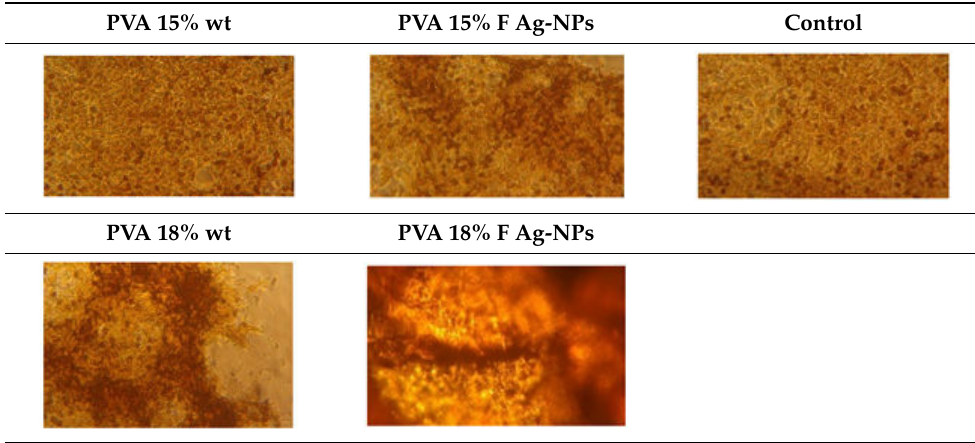
Figure 10. Alizarin red test for pure PVA and PVA/fibroin/Ag-NPs composite membranes on days 3, 7, and 10. Statistical analysis was developed with ordinary one-way ANOVA followed by Tukey’s multiple comparisons test, p < 0.05. **** high significant difference. Table 4. Optical micrographs of calcium deposition on PVA membranes cultured with MG-63 cells, with respect to the control on day